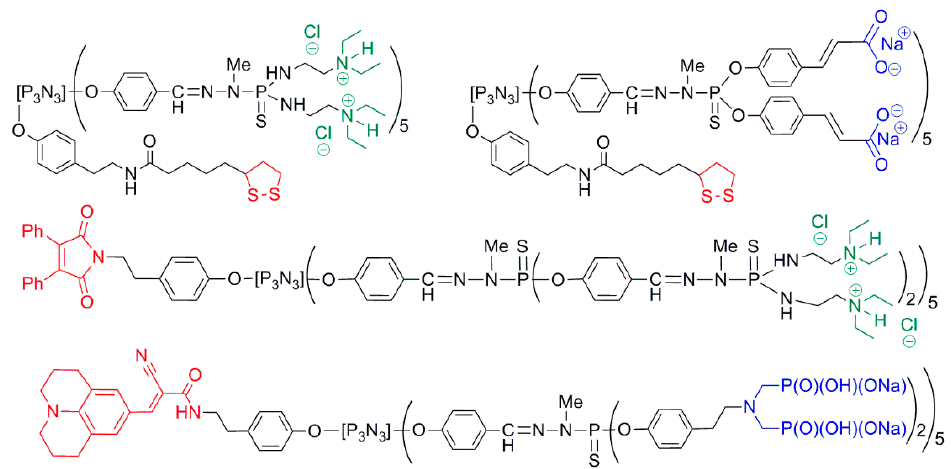
Figure 6. Examples of dendrimers with an off-center function linked to the core; top : dithiolane for the grafting to gold surfaces; middle: fluorescent maleimide group; bottom : fluorescent julolidine group.